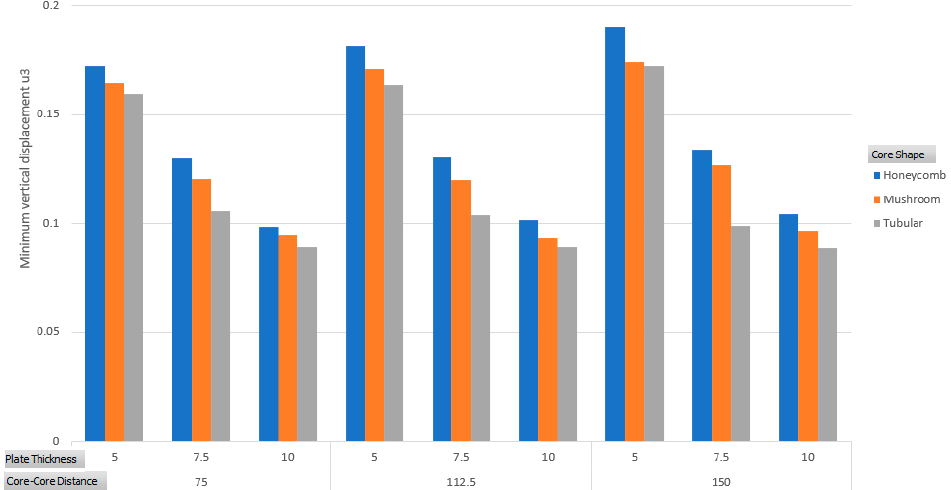
Figure 13. Maximum U3 displacement categorized by core shape, plate thickness, and core–core spacing.